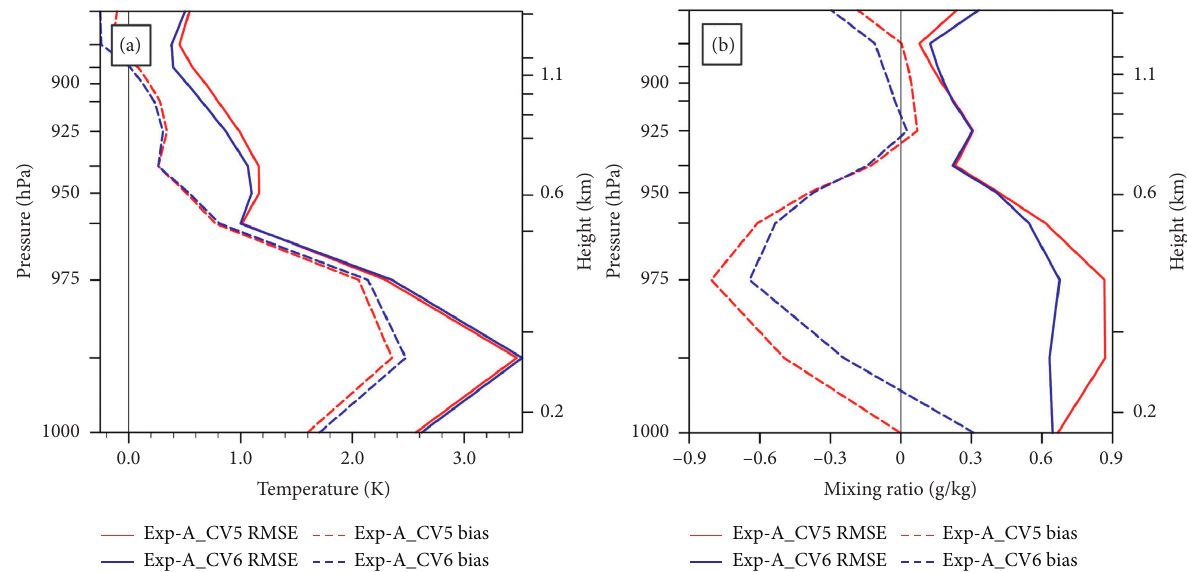
Figure 8: Vertical profiles of root mean square errors (RMSEs) (solid lines) and biases (dashed lines) between the initial analysis and the radiosonde observations of temperature (a) and mixing ratio (b) for Exp-A_CV5 and Exp-A_CV6.